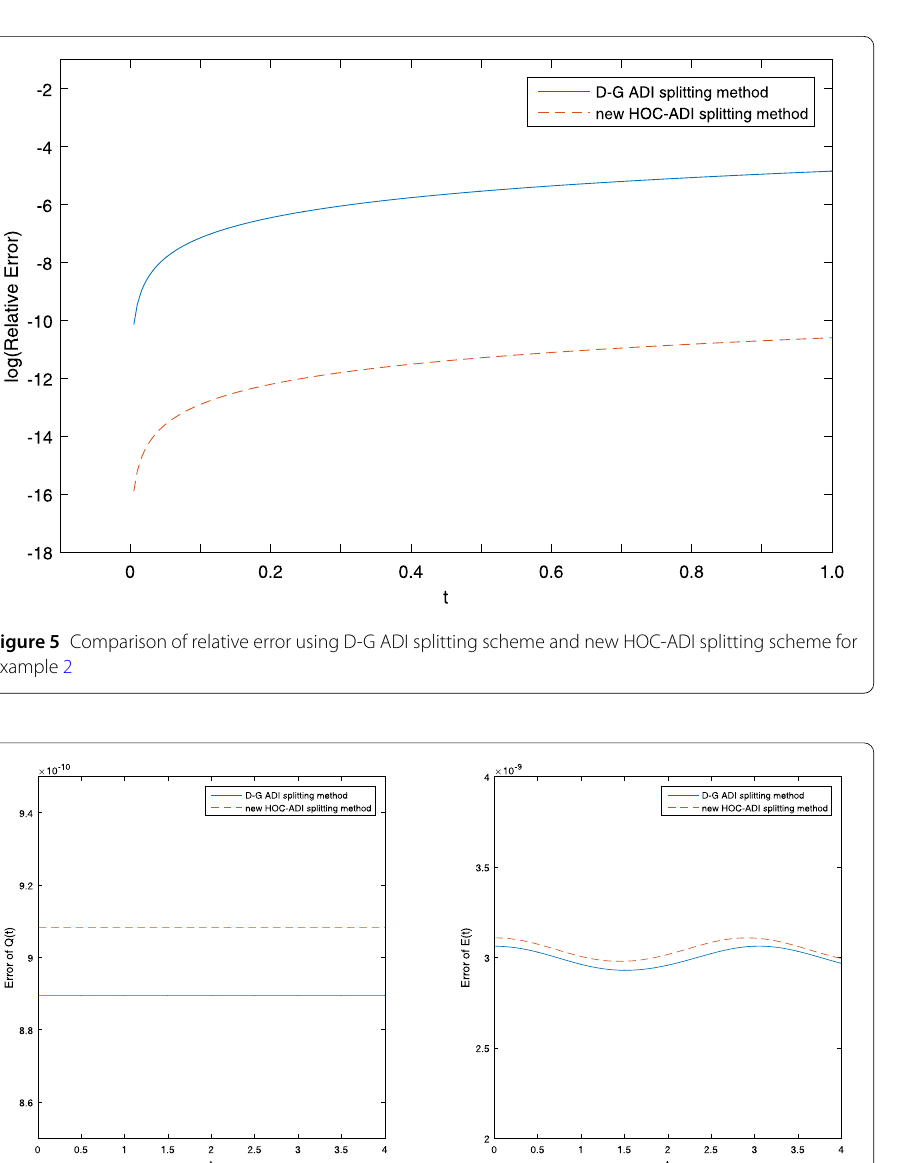
results show that the proposed methods are efficient and accurate for numerically solving 3D Schrödinger